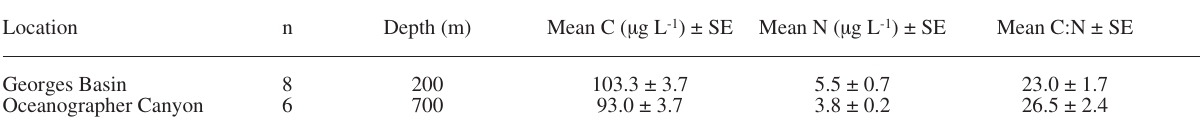
Table 3. – Carbon and nitrogen composition of seston. C, carbon; n, nitrogen; Se, standard error. location